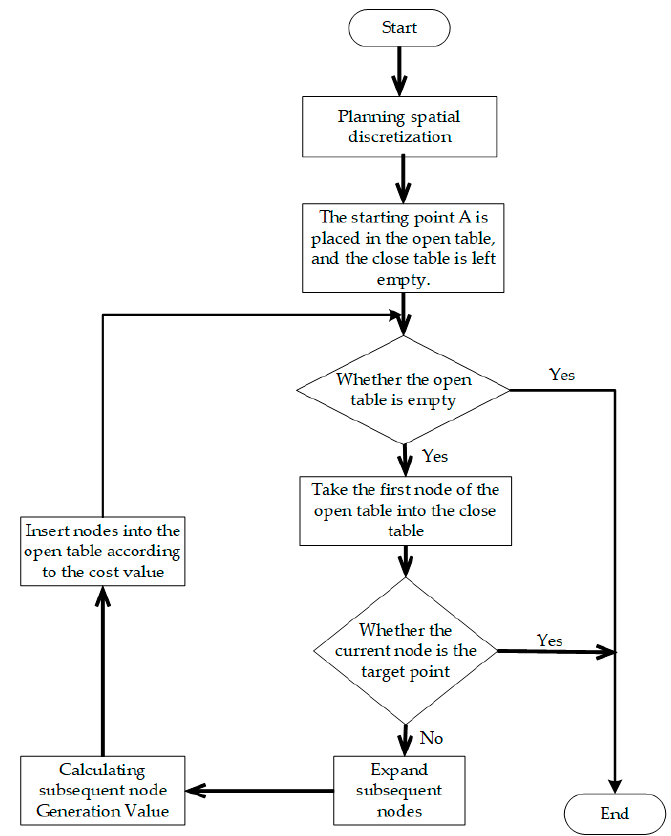
Figure 10. Flow chart of the improved sparse A* algorithm.